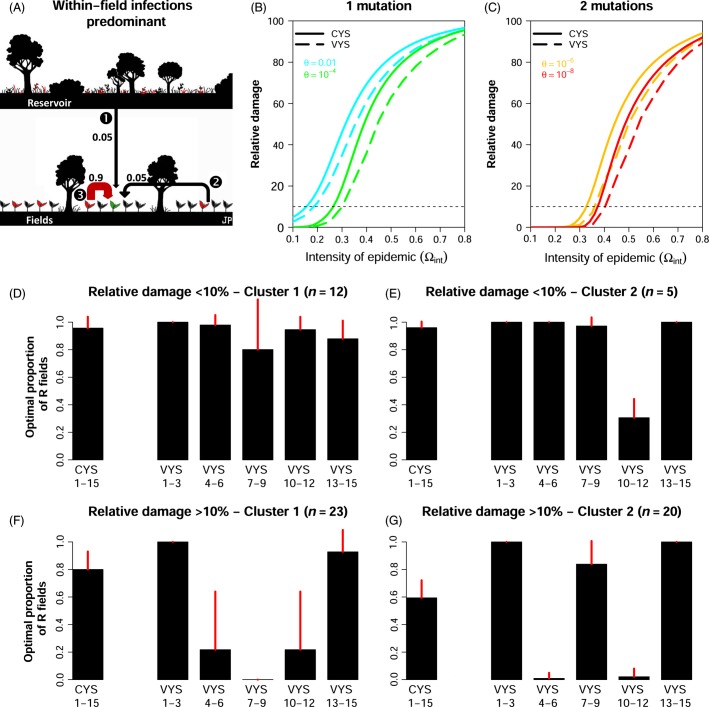
Comparison of the damage reduction achieved with constant-mixture and variable-mixture yield strategies in a landscape in which epidemic dynamics are driven mostly by within-field infections. (A) In this landscape, before the deployment of the resistant cultivar, 90% of the infections are within-field infections (arrow ). The other two infection routes, from the reservoir (arrow ) and between-field (arrow ), each accounts for 5% of the infection events. (B, C) The effects of resistant cultivar choice (θ) and of epidemic intensity before the deployment of the resistant cultivar () on the relative damage obtained with optimal constant-mixture yield strategies (CYS) and optimal variable-mixture yield strategies (VYS). Values of θ in the range [10−4, 0.01] (resp. [10−8, 10−6]) correspond to resistance genes typically requiring one (resp. two) mutation to be broken down, depending on the fitness costs associated with these mutations. The dotted line indicates relative damage of 10%, above this arbitrary threshold a substantial margin of improvement exists for CYS. (D, E). Clustering in two groups of the time series of the optimal proportion of R fields in VYS when the relative damage obtained with CYS is <10% (17 of the 60 parameter combinations displayed in graphs B and C). Bars show the mean (±standard deviation) of the proportion of R fields to sown in years 1–3, 4–6, 7–9, 10–12, and 13–15, and the proportion to sown with the CYS. (F, G) As for (D, E), but for relative damage obtained with CYS ≥10% (43 of 60 cases).